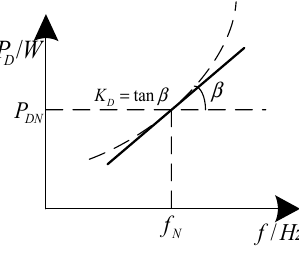
Figure 4. Frequency characteristic curve of loads.